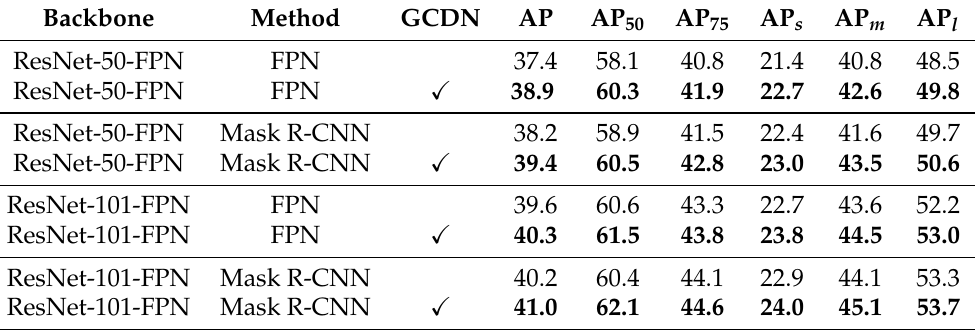
Table 1. Comparisons with baselines on MS-COCO 2017 val .